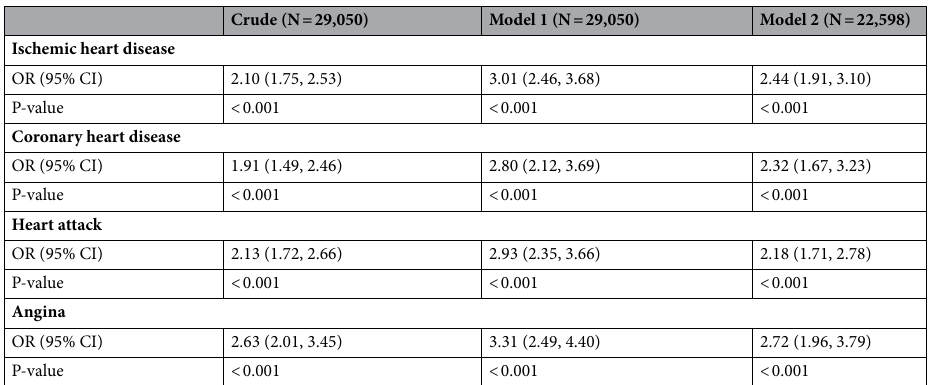
Table 1. Weighted odds ratios (95% confidence intervals) of ischemic heart disease coronary heart disease heart attack and anginas across depressive symptoms, NHANES 2007–2018 (N = 29,050). a Calculated using binary logistic regression. Model 1 adjusted for age, gender. Model 2 adjusted for age, gender, ethical groups, educational level, household income, caffeine intake, total energy intake, smoking, alcohol consumption, work activity, recreational activity, diabetes, hypertension and